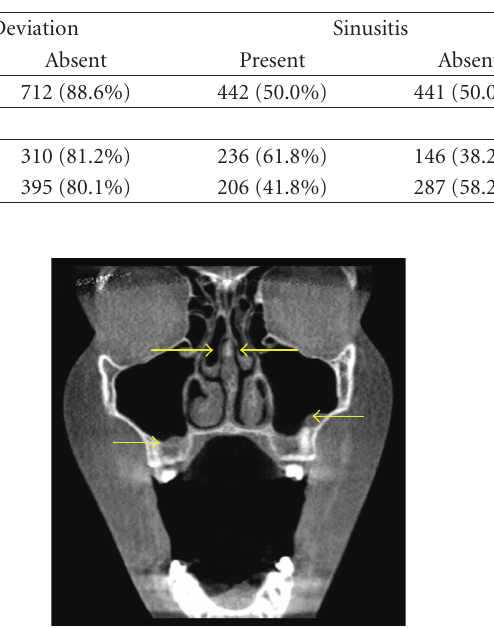
Figure 3: Coronal CT scan demonstrating bilateral maxillary sinusitis (arrows). The degree of sinus inflammation is more prominent in the right sinus. Concha bullosa or nasal septal deviation are not noted.